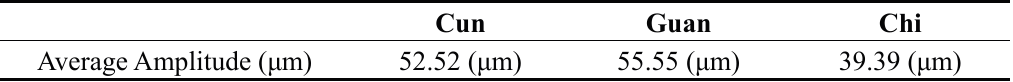
Table 2. Average amplitude ( μ m) corresponding to the main frequencies of cun, guan and chi pulses. Cun Guan Chi Average Amplitude ( μ m) 52.52 ( μ m)